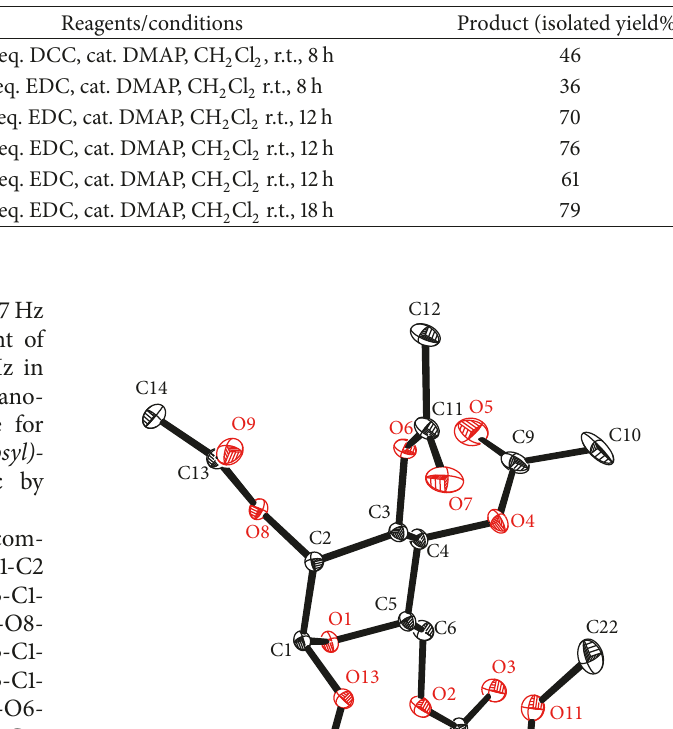
Table 1: Different coupling condition for amide synthesis.